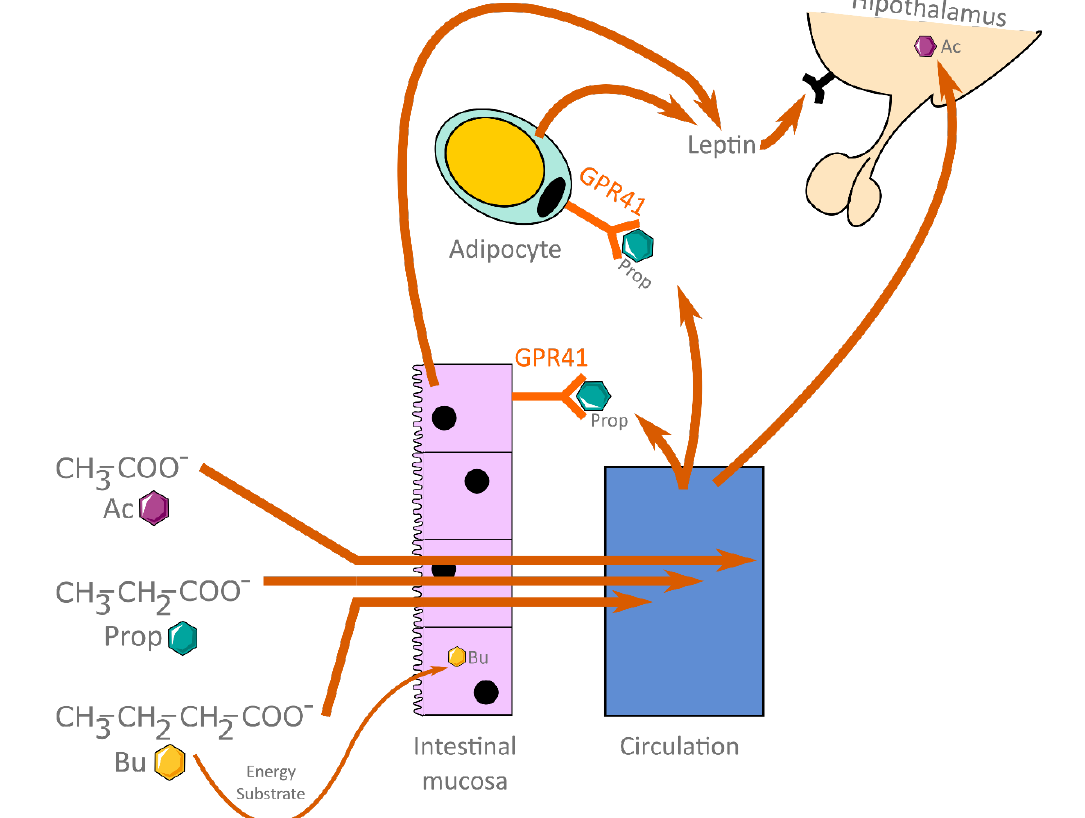
Figure 1. Summary of the key effects of the three main SCFAs. Abbreviations: Ac, acetate; Prop, propionate; Bu, butyrate; GRP, G protein-coupled receptor. The Figure was partly generated using